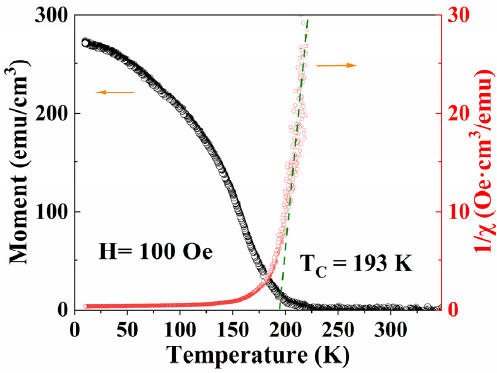
Figure 3. The M(T) and 1/ χ (T) curves under FC conditions for PSMO-7 film on SrTiO 3 at a magnetic field of 100 Oe. field of 100